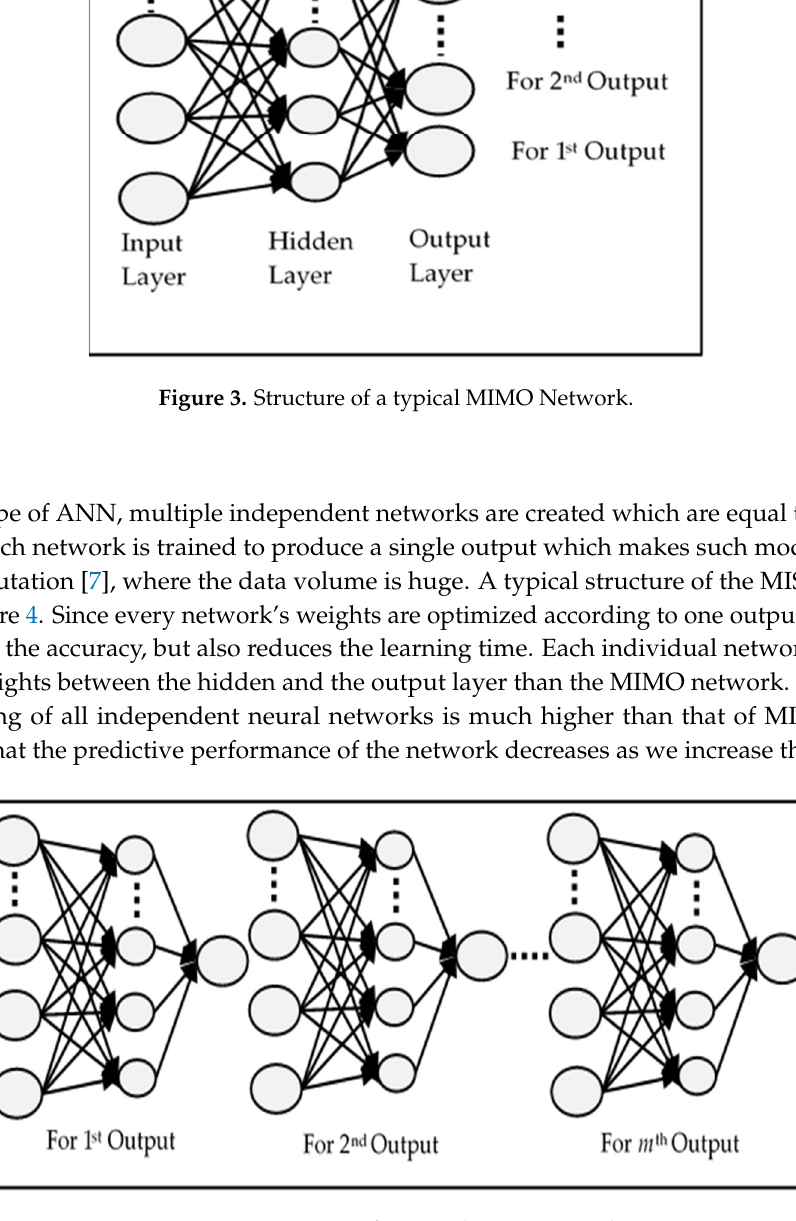
Figure 4. Structure of a typical MISO